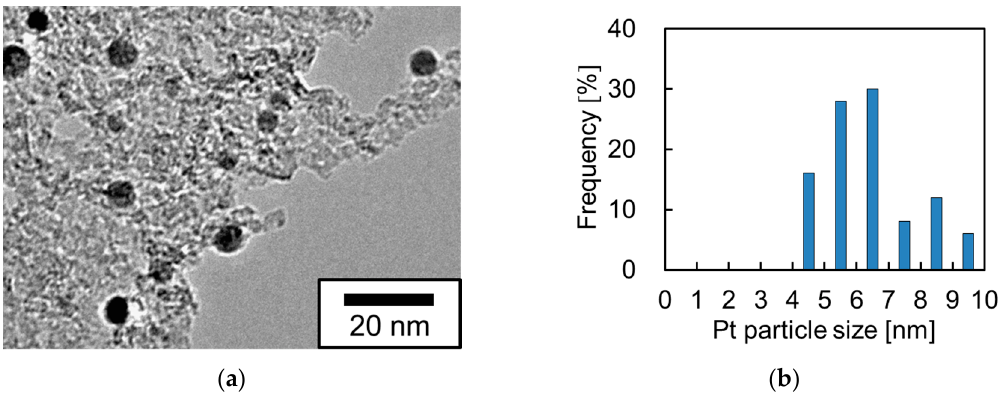
Figure 2. ( a ) TEM image and ( b ) particle-size distribution of Pt-particle/ABS sample synthesized by an electron-beam irradiation reduction method (EBIRM).